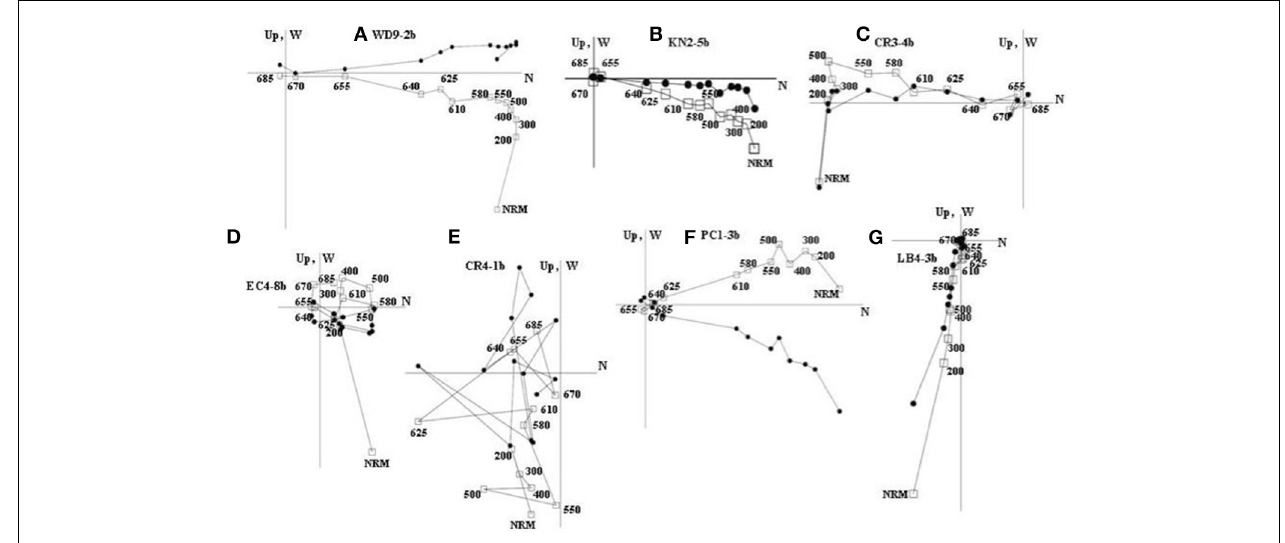
FIGURE 3 | Examples of demagnetization results; (A,B) are examples of northerly, shallow directions typical of the Moenave Formation; (C) is reversed polarity from the Wingate Formation; (D) (Moenave) and (E) (Wingate) did not yield clear directions